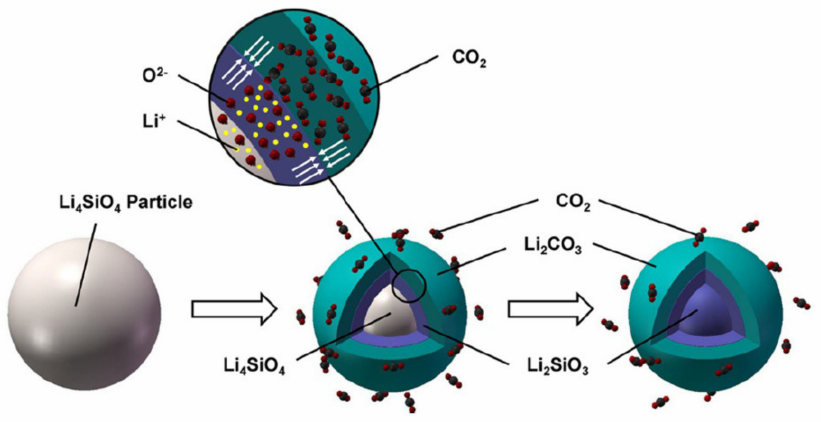
Figure 12. Scheme of double shell structure for the CO 2 sorption process in Li 4 SiO 4 . (Reprinted with permission from [113]. 2016, Yang et